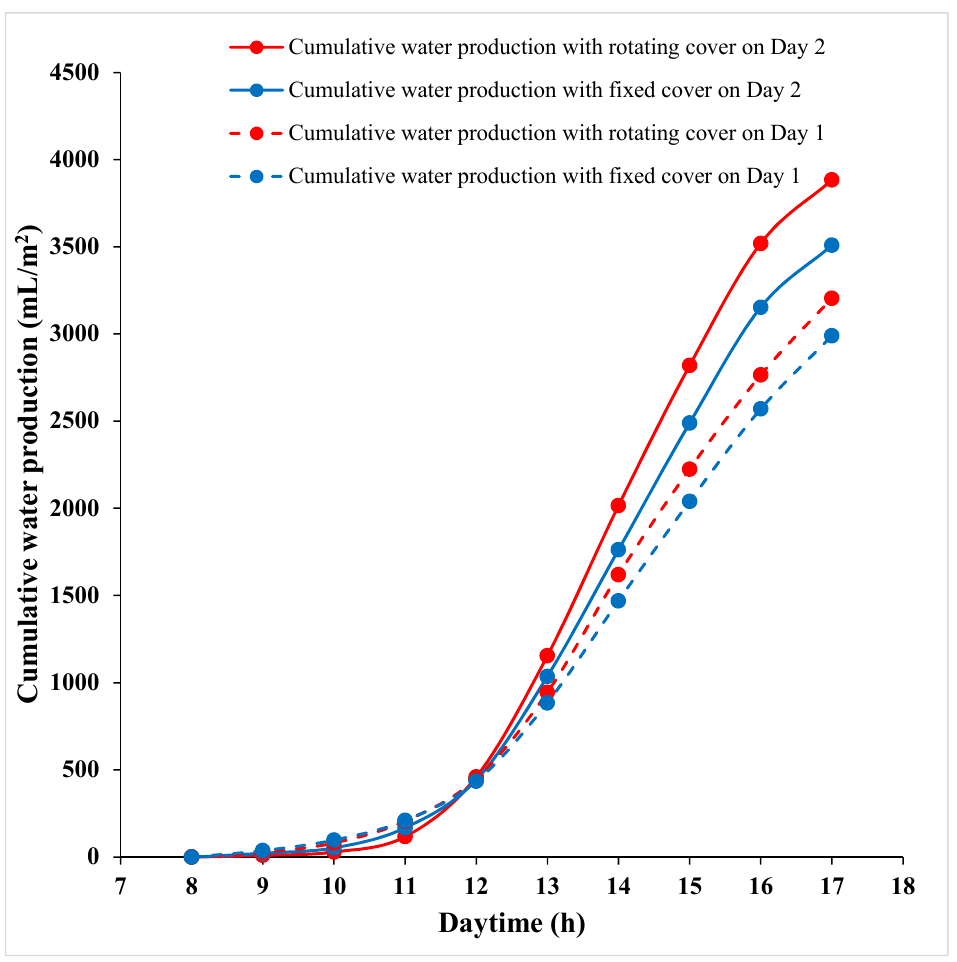
Figure 8. Cumulative water production for 27 August (day 1) and 28 August (day 2) 2021, where the cylindrical cover is fixed or rotates.